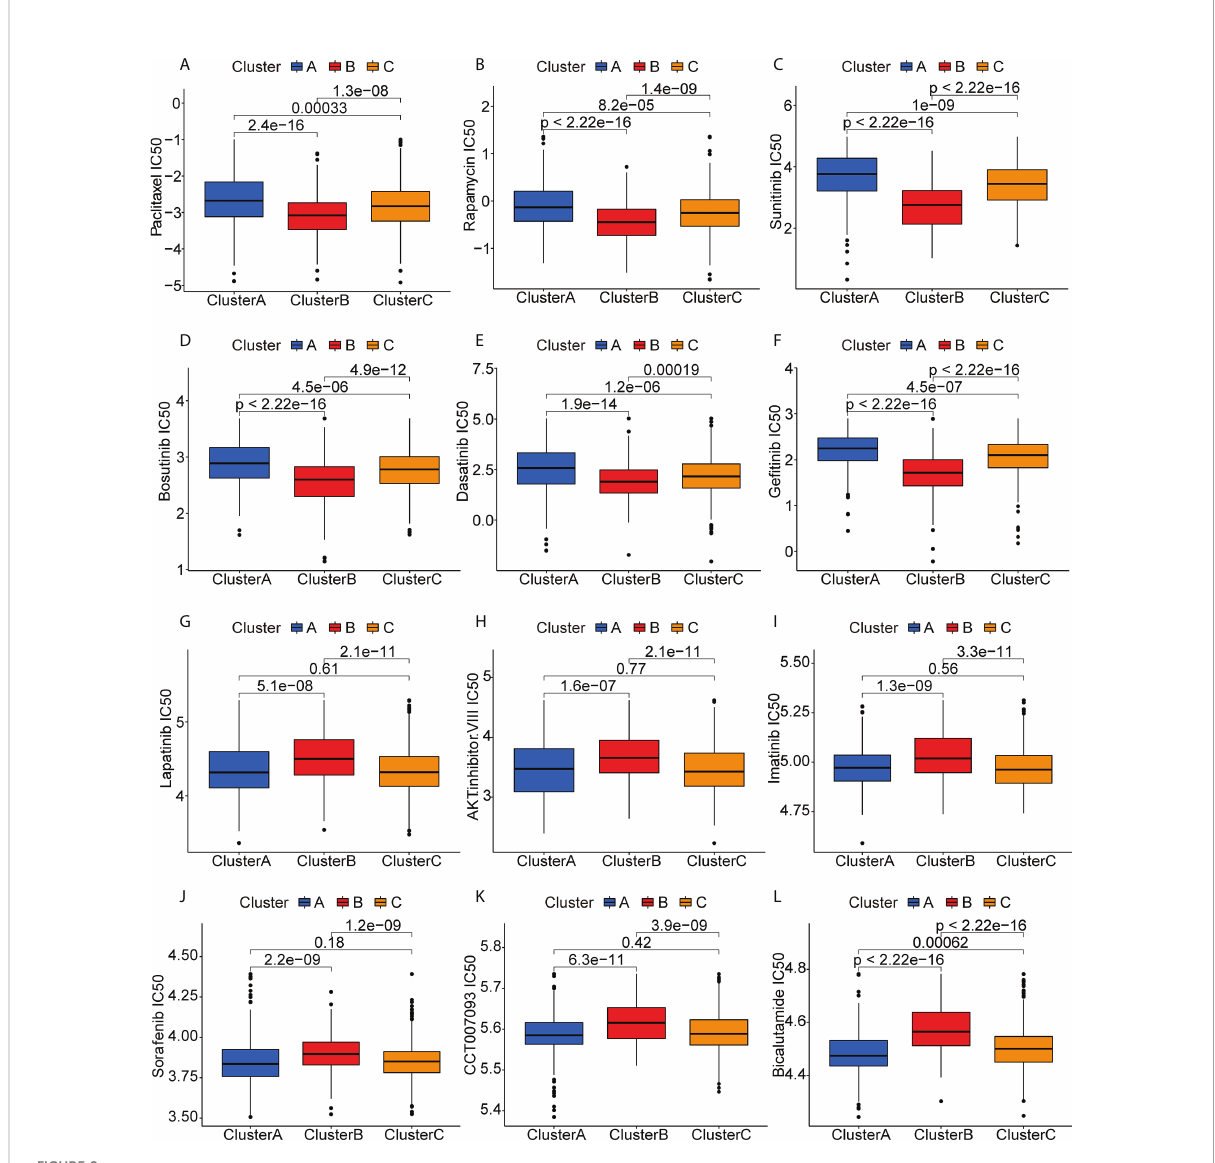
FIGURE 8 Anticancer drug sensitivities of patients in the different clusters. (A-L) IC50 values of anticancer